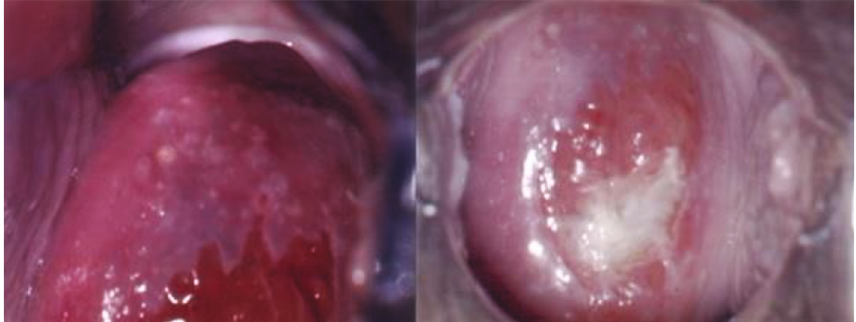
Figure 1: Colposcopy: normal cervix.